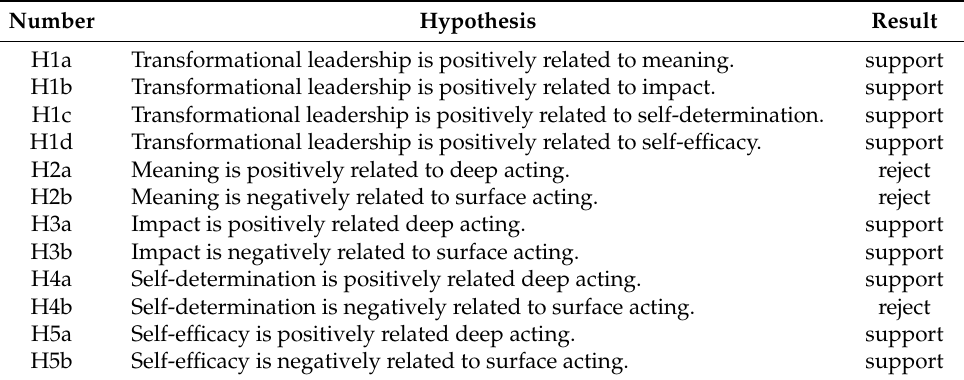
Table 6. Hypothesis test